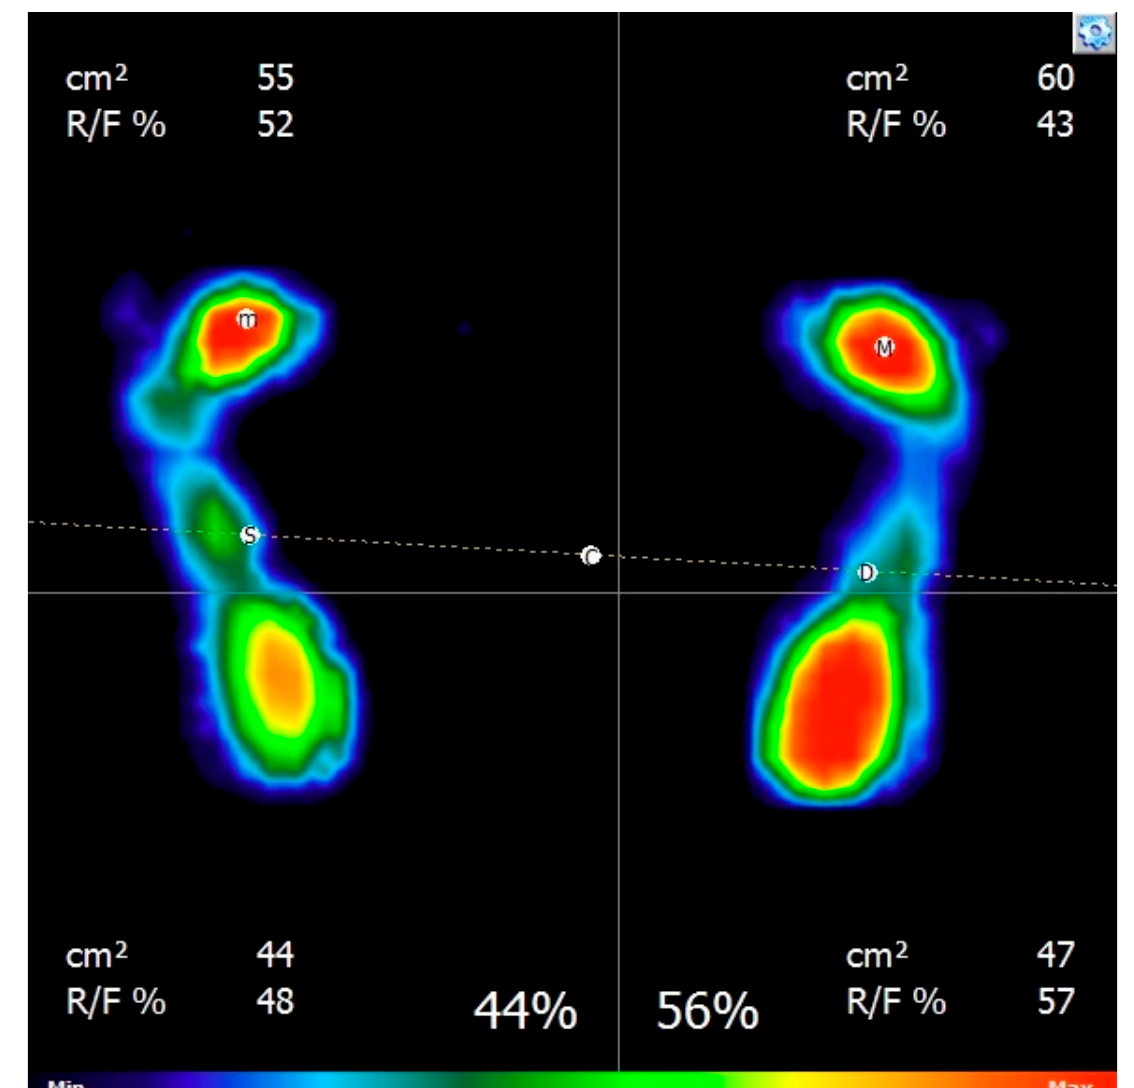
Figure 2. Image data obtained after the static test of the baropodometric examination. R—rear of the foot; F—front of the foot.